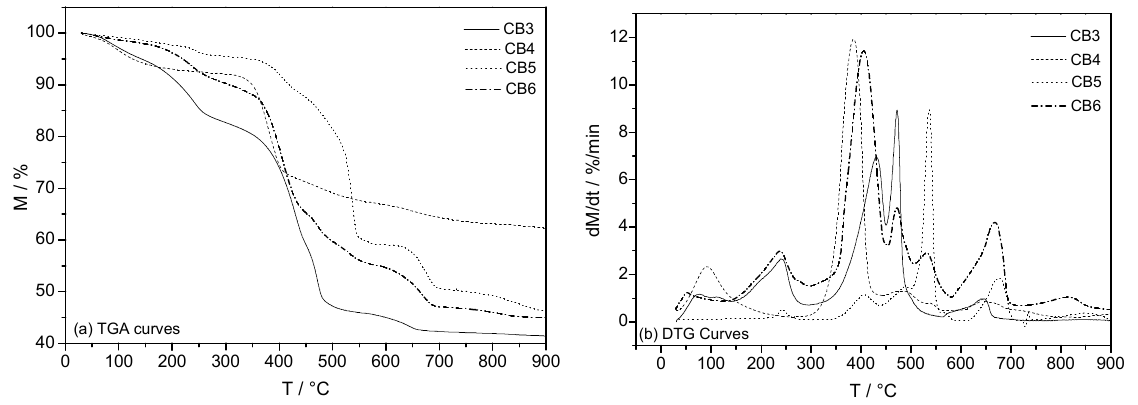
Figure 12. ( a ) TGA and ( b ) DTG curves of products obtained from the CB3, CB4, CB5, and CB6 experiments.